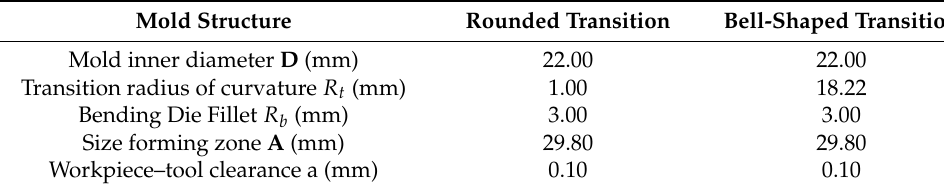
Figure 3. Mechanism of the 3D-FBF technology. Table 1. The structure of the bending die and assembly parameter setting. Table 1. The structure of the bending die and assembly parameter